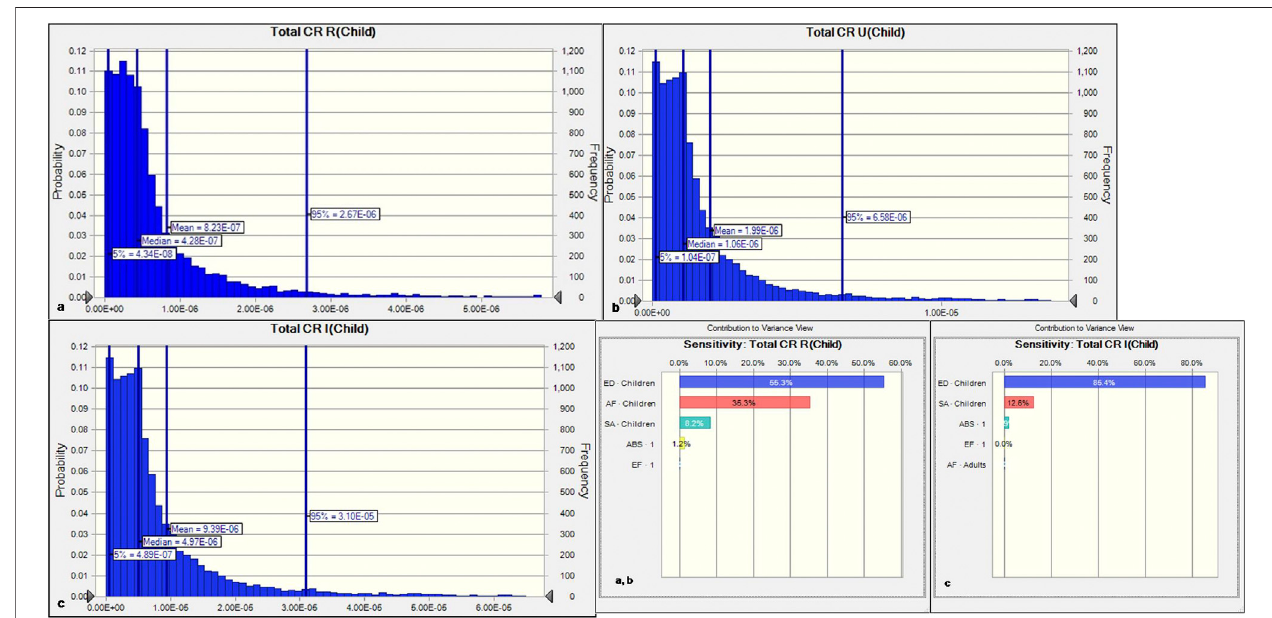
FIGURE 3 | Probability density functions and sensitivity chart from Monte Carlo simulations used to predict the cancer risk from soil-bound PAHs for children (A) and adults (B) in Ulsan residential (C) areas.